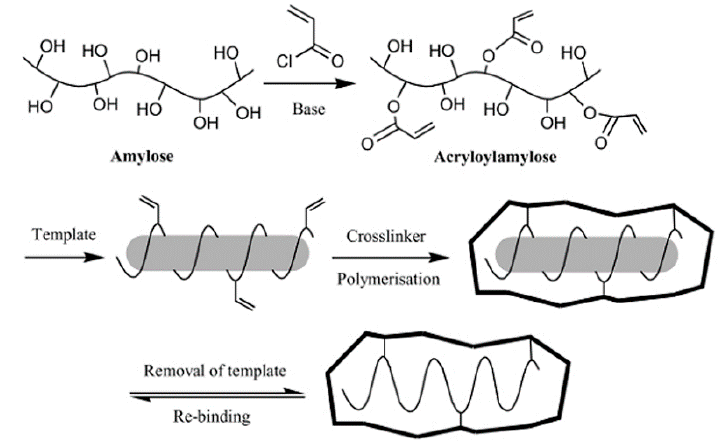
Figure 5. Outline of molecular imprinting using amylose. Reprinted with permission from Reference 103. Copyright 2002, Royal Society of Chemistry.